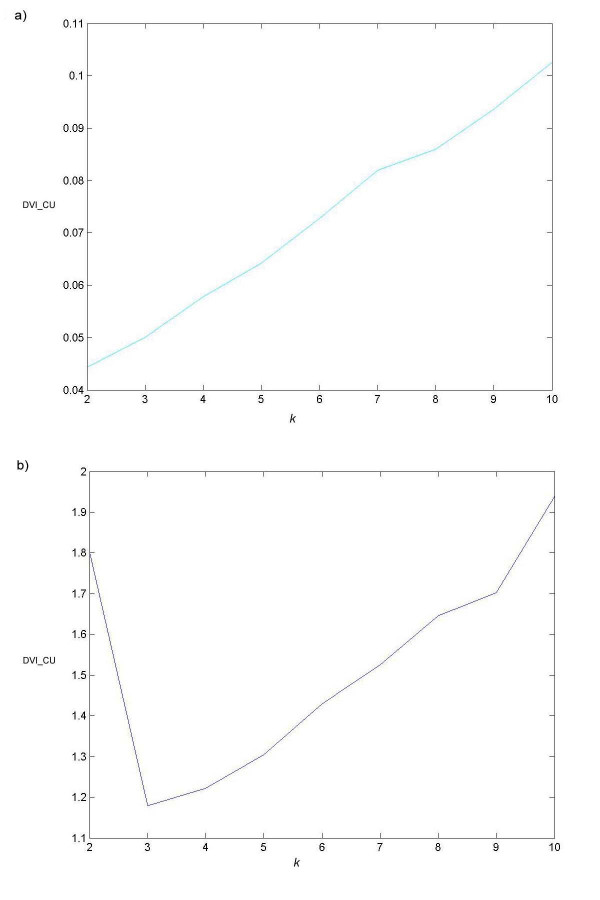
Determination of k clusters in the heart disease and acetaminophen data sets using modk-prototypes. The a) heart disease data and b) acetaminophen data were clustered using the modk-prototypes algorithm at values of k increasing from 2 to the N number of samples in the data. DVI_CU (on the y axis) was computed and plotted for the clustering of the data at each value of k (on the x axis). Only k = 2 to 10 is shown.